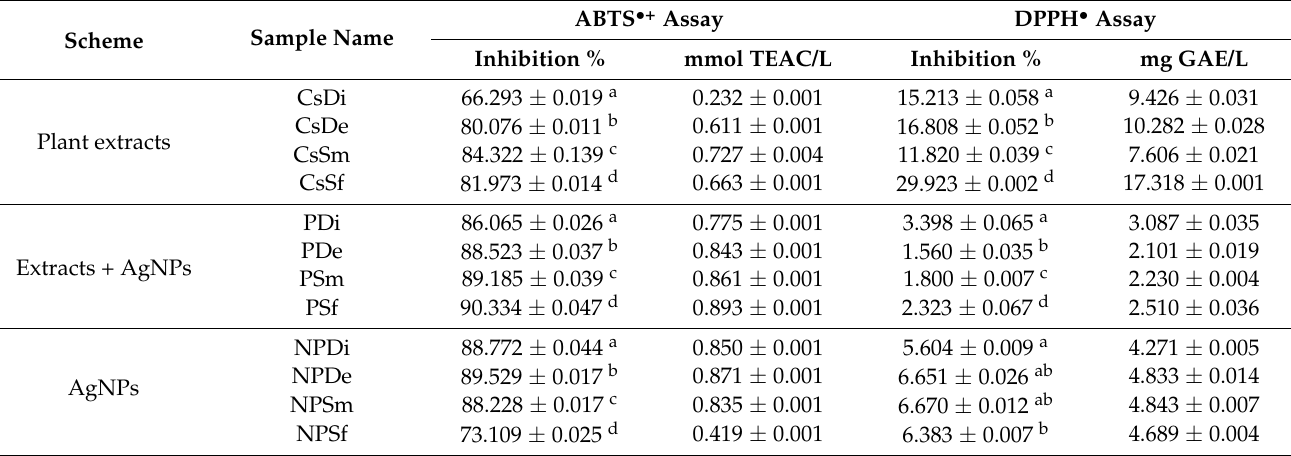
Table 3. The antioxidant activity was determined by ABTS • + and DPPH • assays, respectively, performed for the leaves extracts, the mixture of leaves extracts and AgNPs, and purified AgNPs. The analyses were performed in triplicate ( n = 3). TEAC-Trolox equivalent antioxidant capacity; GAE-gallic acid